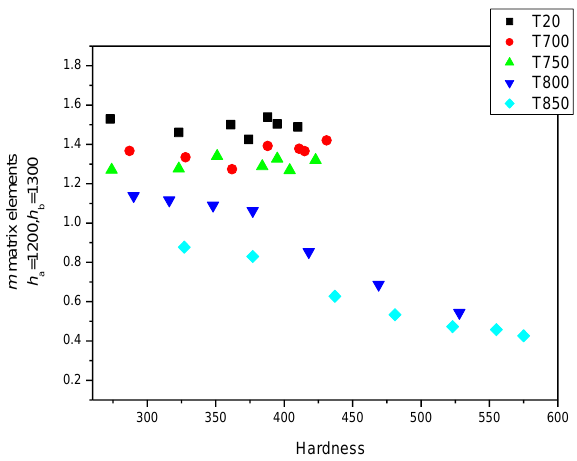
Figure 16 . ( h a = 1200 and h b = 1300) m matrix elements for all samples, indicating the actual heat treatments as functions of the hardness.